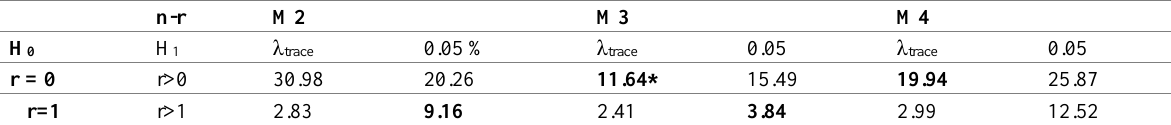
Table 6: Case 3- LNDHE and LNGDP